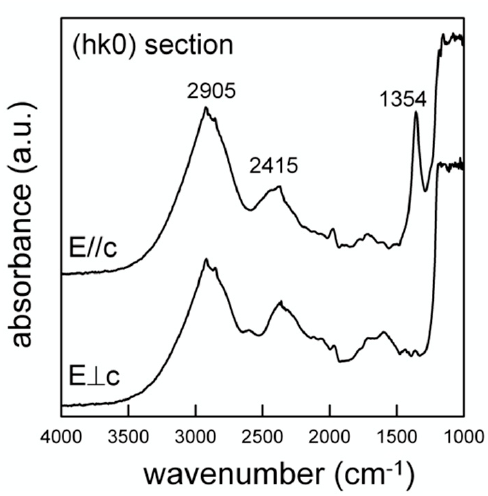
Figure 7. Powder FTIR spectra of whitlockite (blue) and TCP (red, sample from [11]): detail of the tetrahedral modes region (1600–400 cm − 1 ).